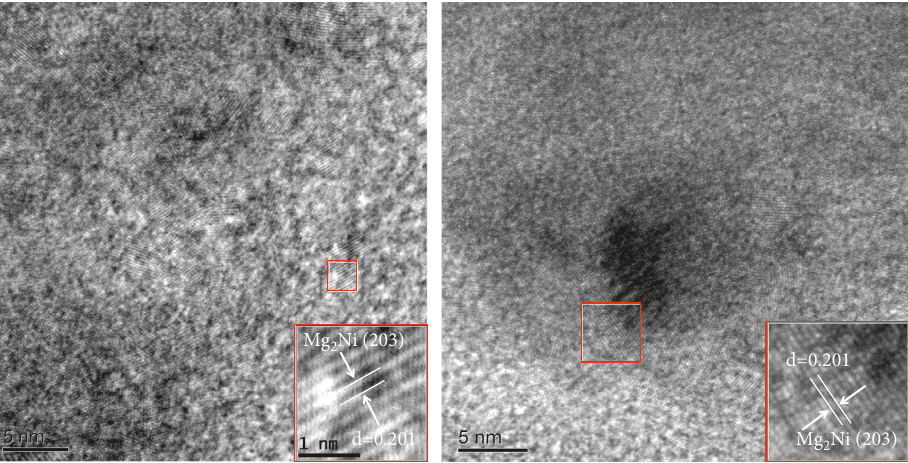
Figure 6: TEM image of HCX-1 ball milling for 21h.